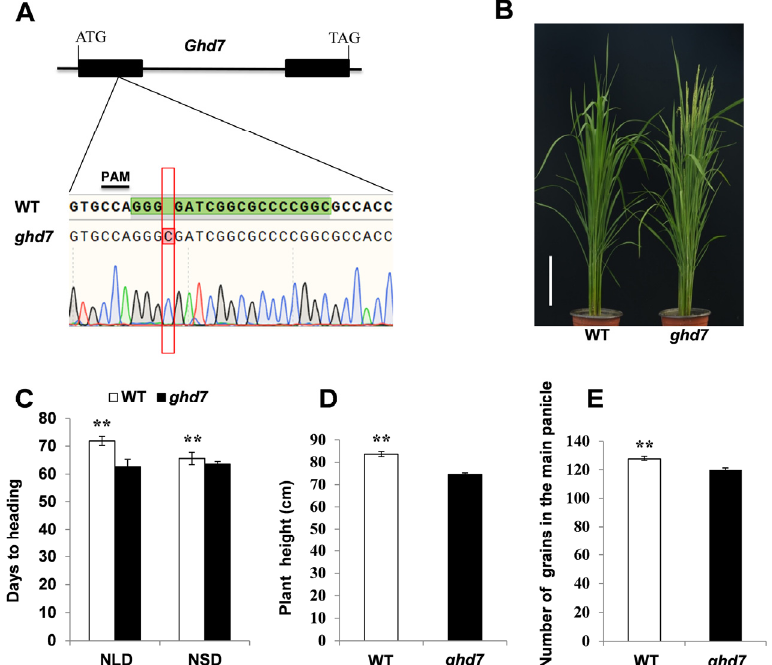
Figure 4. Heading date of wild-type (WT) and ghd7 mutant in the Nipponbare genetic background. ( A ) Schematic of the Ghd7 gene with the sgRNA:Cas9 targets (green) and corresponding protospacer-adjacent motif sequences (underlined). The insertion nucleotide is shown as a red letter. ( B ) The phenotype of WT and mutant ghd7 at the heading stage under Hangzhou conditions. ( C ) Days to heading of WT and ghd7 under natural long-day Hangzhou and natural short-day Hainan conditions. ( D and E ) Comparison of the WT and ghd7 mutant for plant height ( D ) and the number of grains in the main panicle ( E ) under natural long-day conditions. The data are expressed as mean values ± SD. The asterisks ** indicate significance between WT and ghd7 mutant at the p < 0.01, as determined by Student’s t -test.